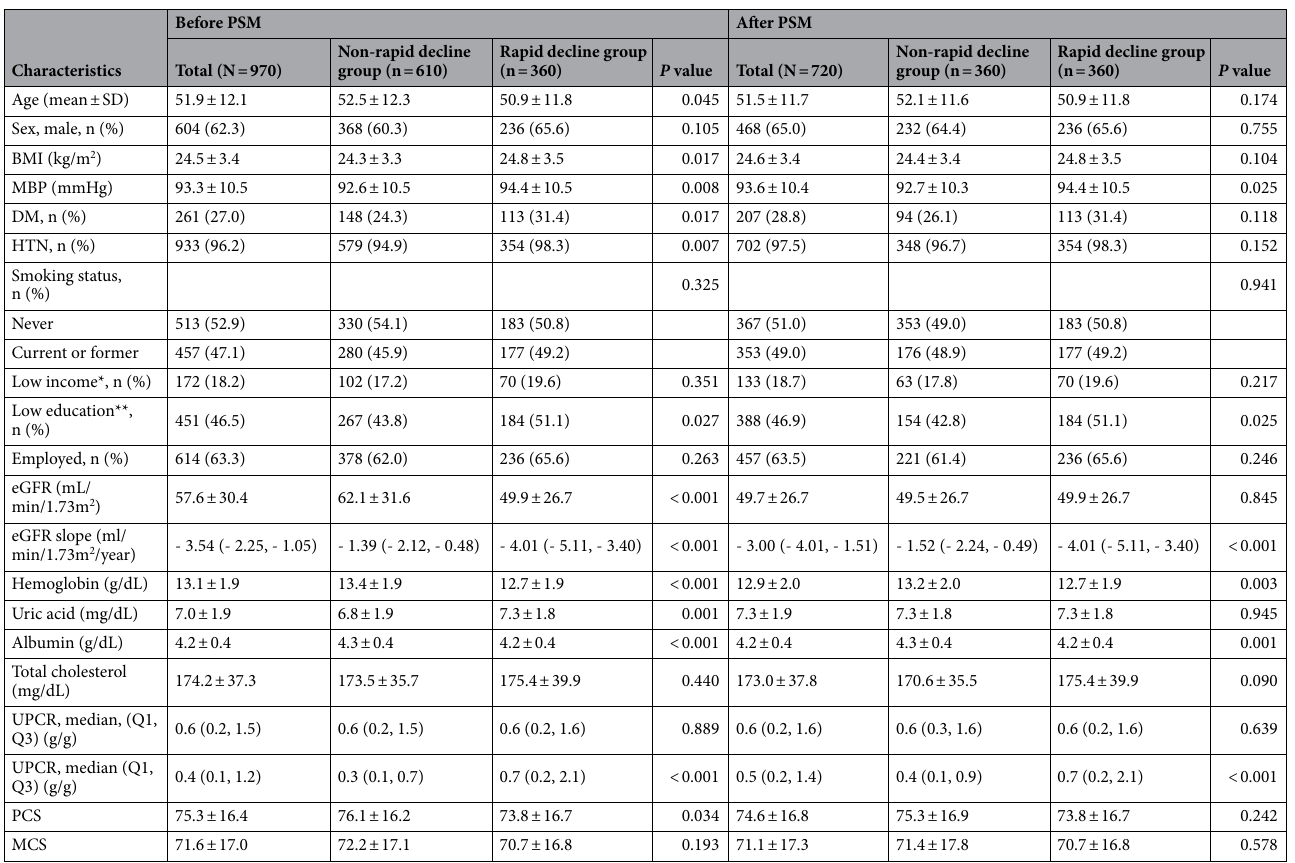
Table 1. Baseline clinical characteristics of patients, stratified according to the presence of a rapid decline in kidney function. The rapid decline in kidney function was defined as a decline in eGFR of > 3